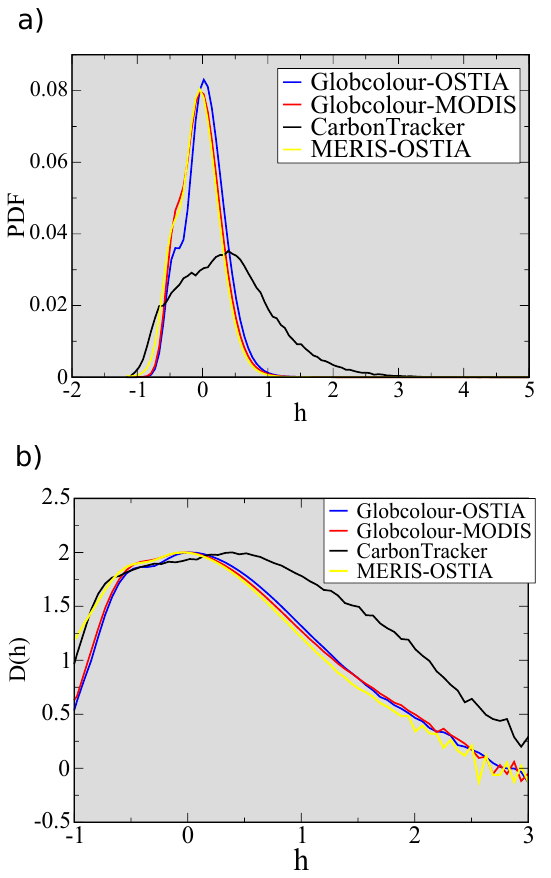
Figure 10. (a) Empirical PDFs for the singularity exponents of p CO 2 fields from CarbonTracker and from the cascade of the three product combinations. (b) Associated singularity spectra. In these computations we use all the p CO 2 values obtained in 2006 and 2008.